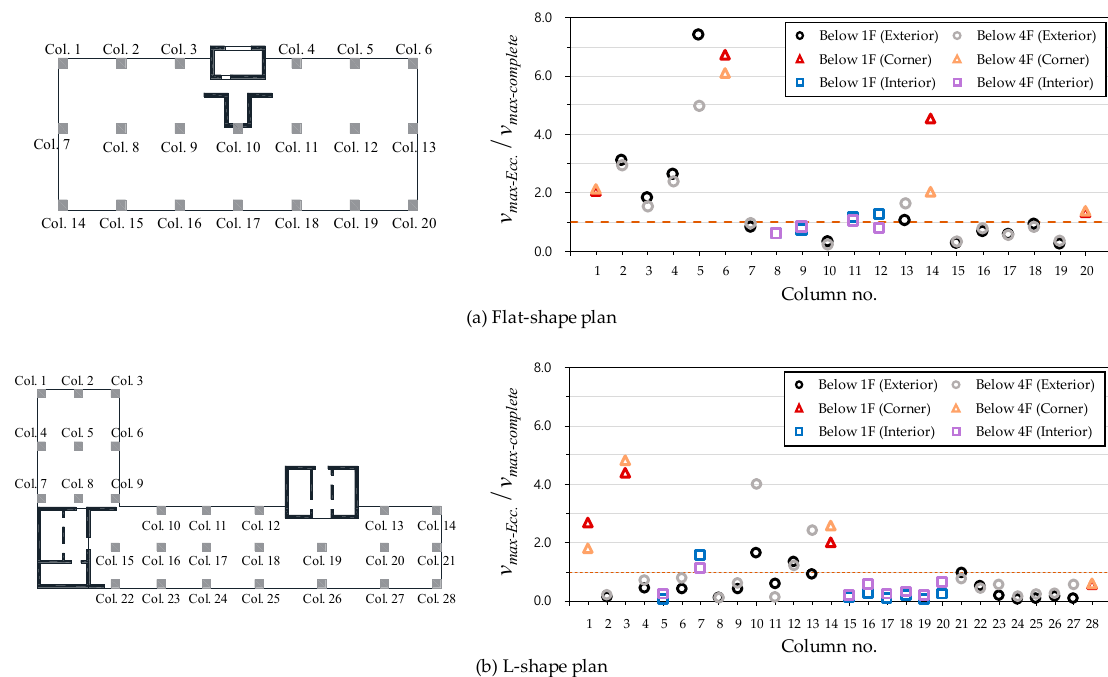
Figure 16. Maximum punching shear stress ratio according to number of stories below transfer plate (for x-dir. lateral load only). ( a ) Flat-shape plan and ( b ) L-shape plan.